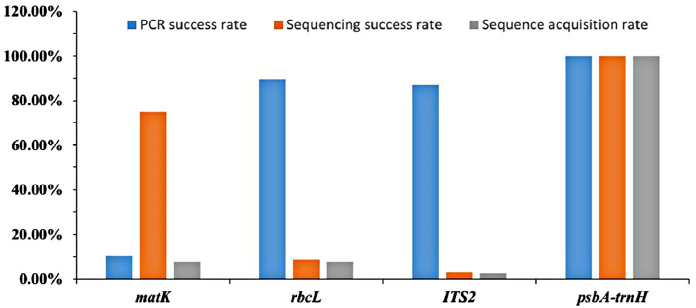
Figure 1. The success rates of PCR amplification, sequencing, and sequence acquisition.